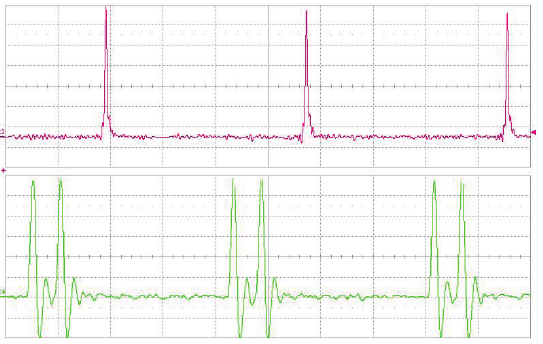
Figure 6. Oscillograms of dual-pulse regime, 1.06 µ m pump (upper trace), PPLN OPO radiation at 1.53 µ m (lower trace). Time scale is 2 ns/div.